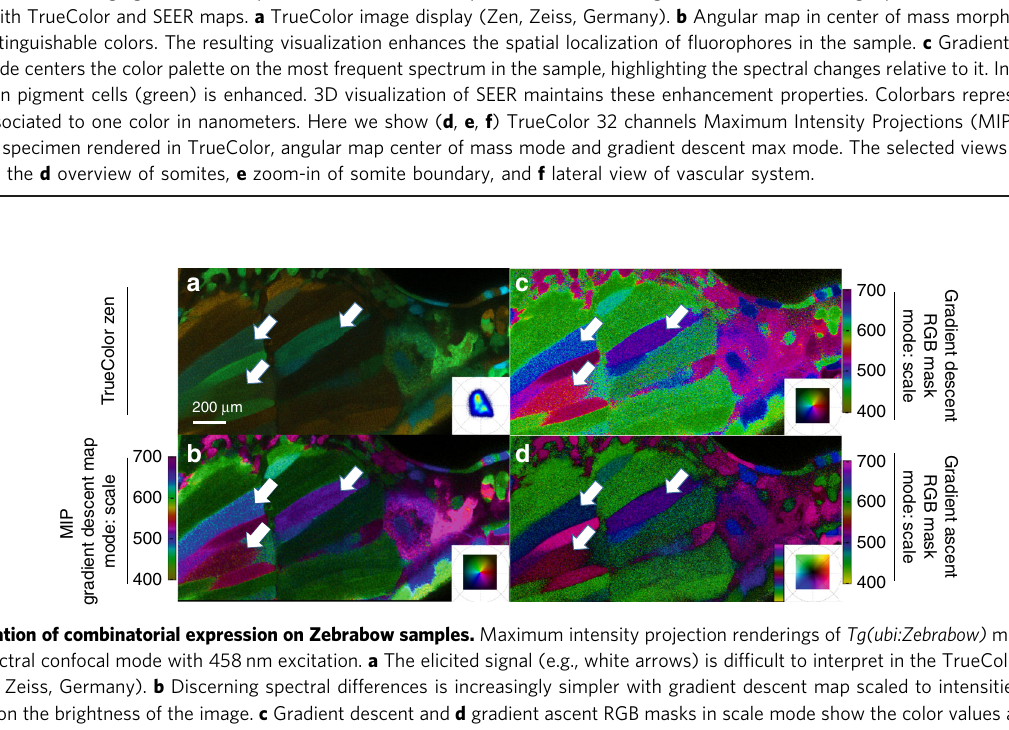
Fig. 6 Triple label fl uorescence visualization. Zebra fi sh embryo Tg(kdrl:eGFP); Gt(desmin-Citrine);Tg(ubiq:H2B-Cerulean) labeling, respectively, vasculature, muscle, and nuclei. Live imaging with a multispectral confocal microscope (32-channels) using 458 nm excitation. Single plane slices of the tiled volume